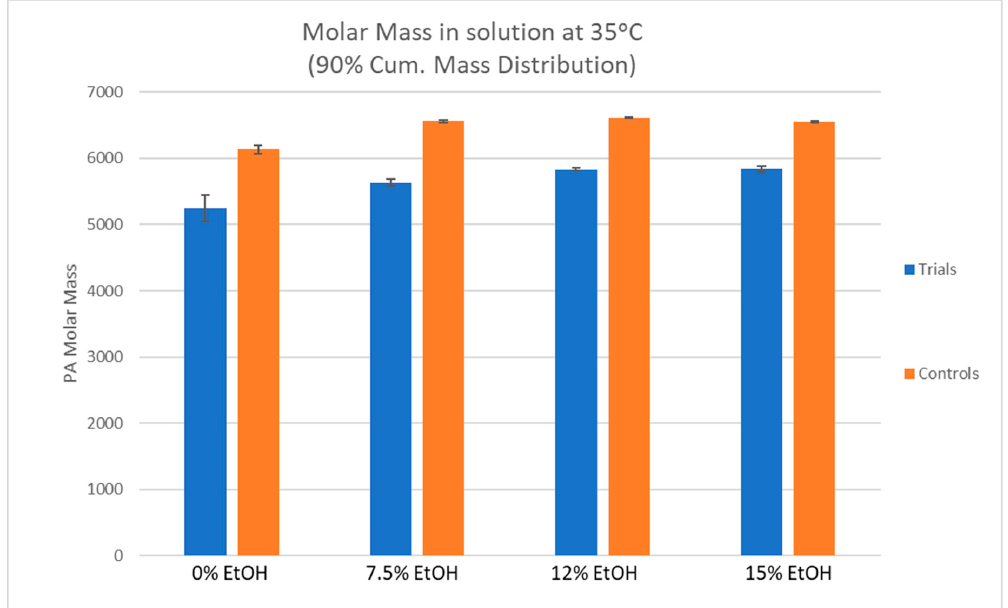
Figure 5. The results of gel permeation chromatography (GPC) analysis comparing molar mass (at 90% cumulative mass distribution) of trial and control solutions at the end of the desorption experiments (samples taken at 35 °C).